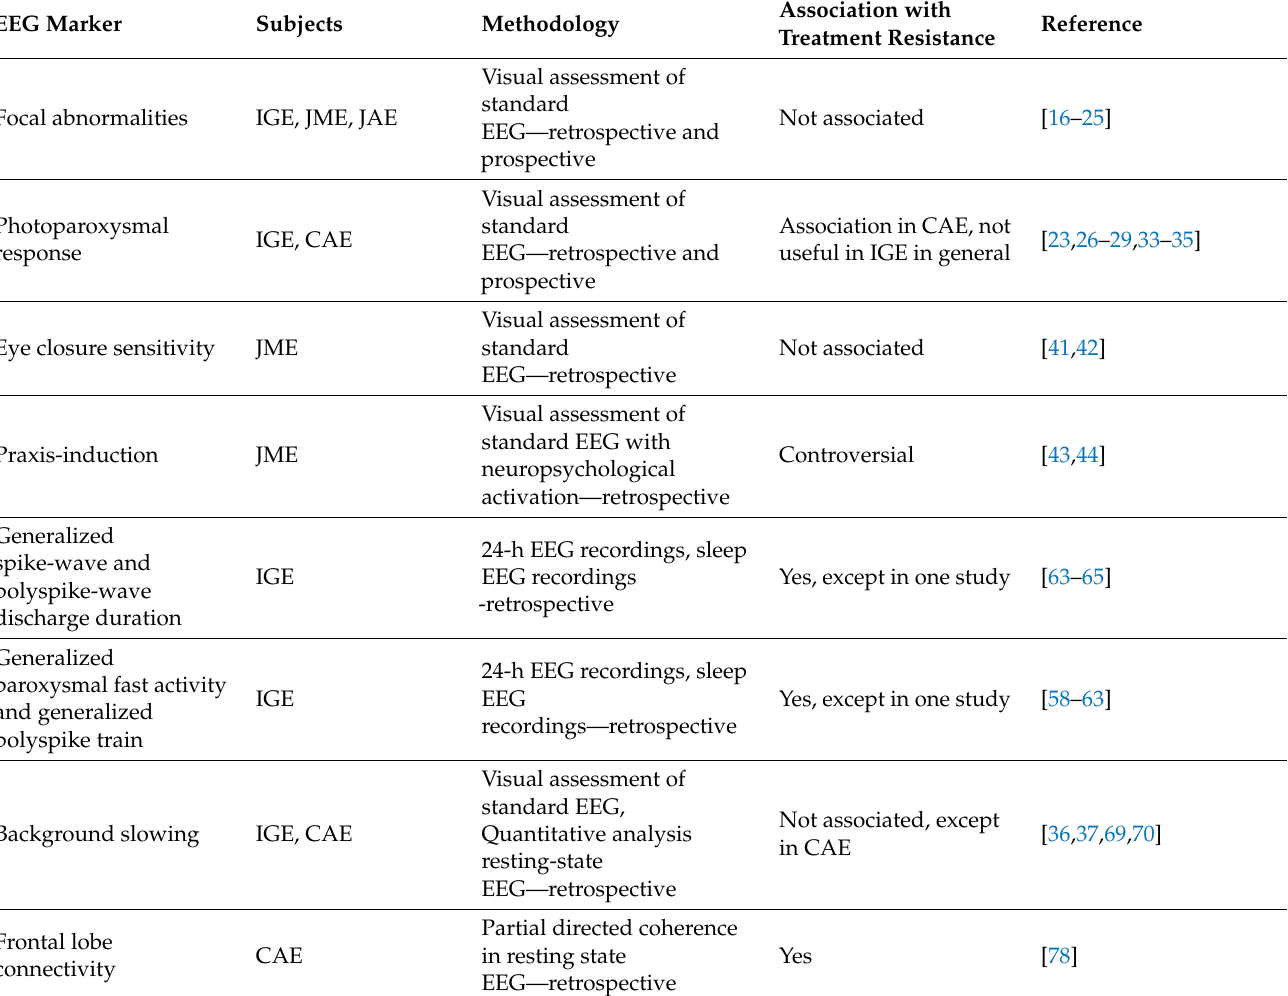
Table 1. EEG markers associated with treatment resistance in idiopathic generalized epilepsy: a summary of current literature